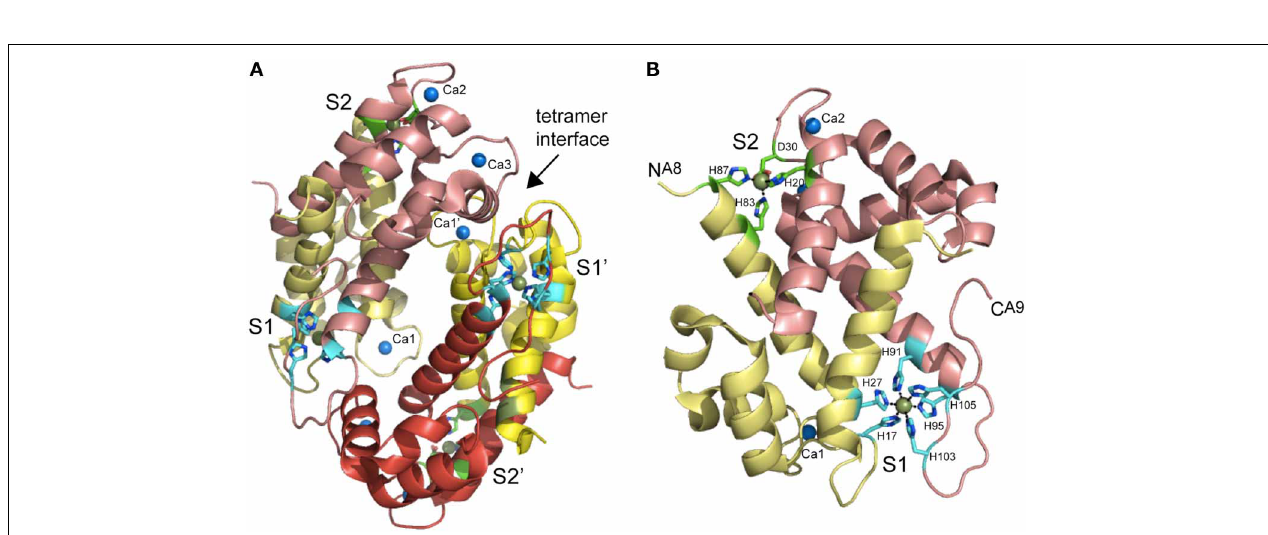
FIGURE 6 | Ribbon representation of the structure of the Mn(II)-bound CP heterotetramer (A) and S100A8-S100A9 heterodimer (B) (Damo et al., 2013). S100A8 chains are shaded in yellow and pale yellow , while S100A9 chains are shaded in red and salmon . The tetramer interface between the two heterodimers is marked. The two intersubunit Mn ions per heterodimer